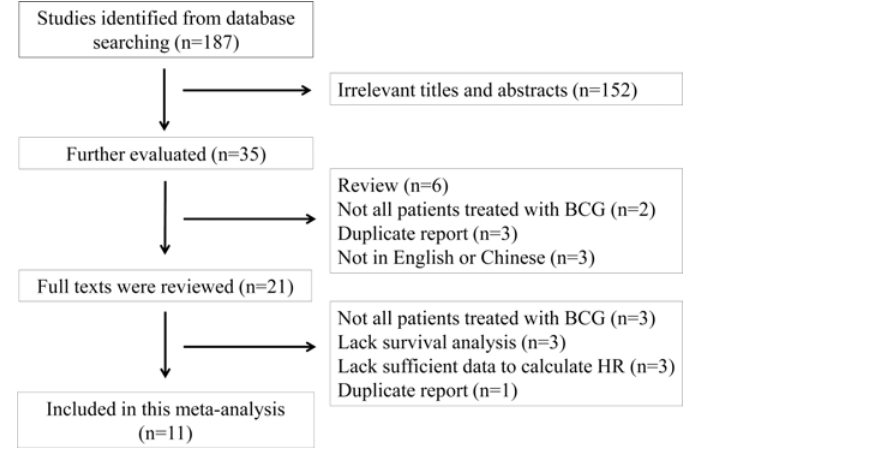
Fig 1. Flowchart of study selection.